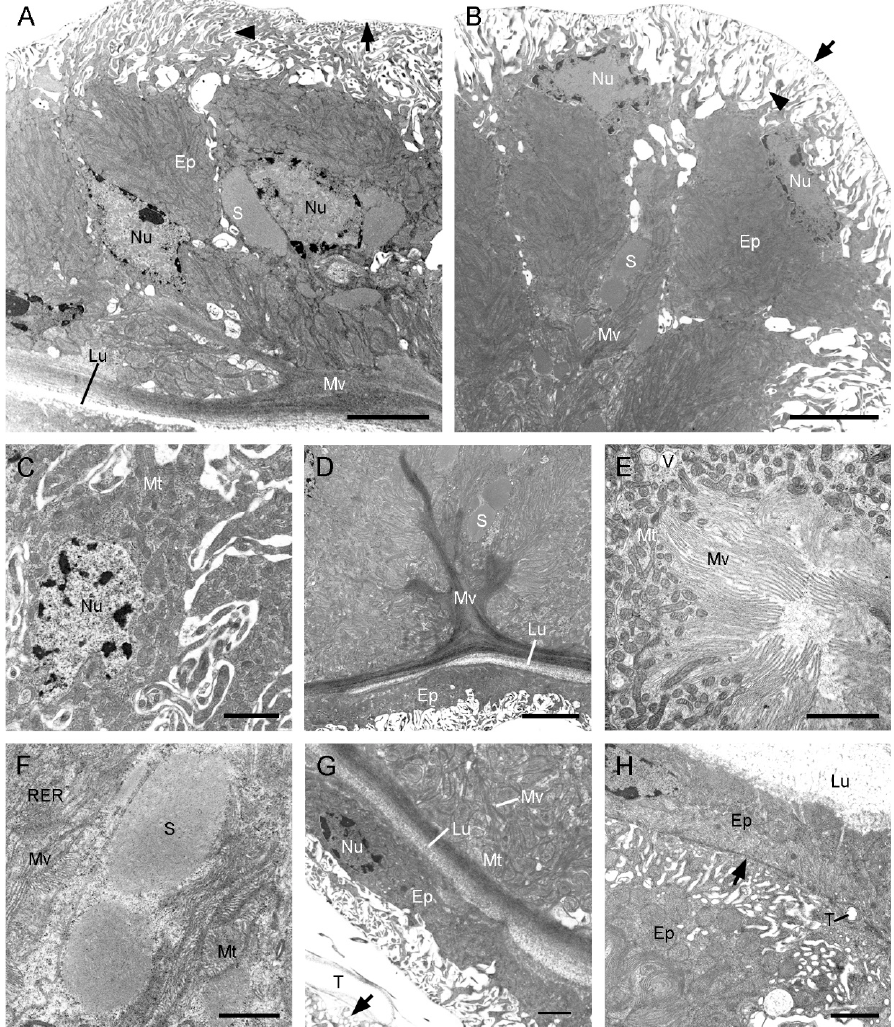
Figure 6. Accessory sac of the ejaculatory duct of Furcatopanorpa longihypovalva , cross-sections, TEM. ( A ) Epithelium. Arrow points to the basal lamina. Arrowhead points to the intracellular spaces. ( B ) Microvilli project into the medial epithelium with granules. Arrow points to the basal lamina. Arrowhead points to the intracellular spaces; ( C ) irregular nucleus and surrounding mitochondria. ( D ) Microvilli cluster. ( E ) Mitochondria near by the base of microvilli; ( F ) granules surrounded by microvilli and rough endoplasmic reticulum. ( G ) Inner side of the epithelium. Arrow shows the epithelium of the median duct. ( H ) Junction of accessory sac and the median duct. Arrowhead points to the muscular layer. Ep, epithelium; G, granule; Lu, lumen; Mt, mitochondrion; Mv, microvillus; Nu, nucleus; RER, rough endoplasmic reticulum; T, tracheole. Scale bars: ( A , B , D ) = 5 μ m; ( C , E , G , H ) = 2 μ m; ( F ) = 1 μ m.